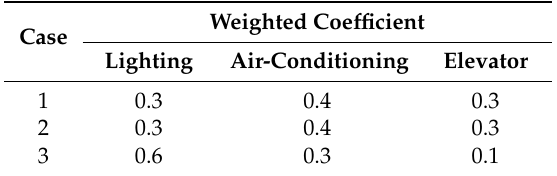
Table 5. Weighted coefficient of each system in different scenes.